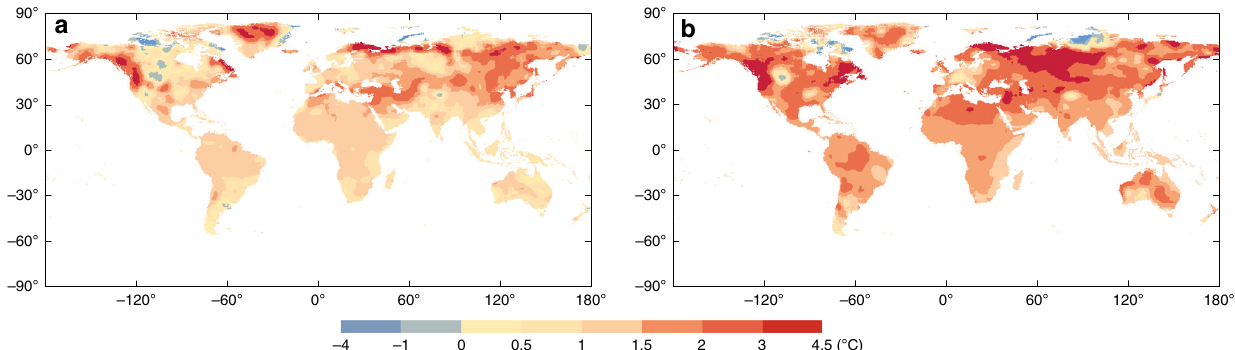
Fig. 5 The distributions of change of most frequent temperature (MFT) in the 2050s compared to the 2010s under RCP4.5 ( a ) and RCP8.5 ( b ) scenarios for each 0.5° × 0.5°